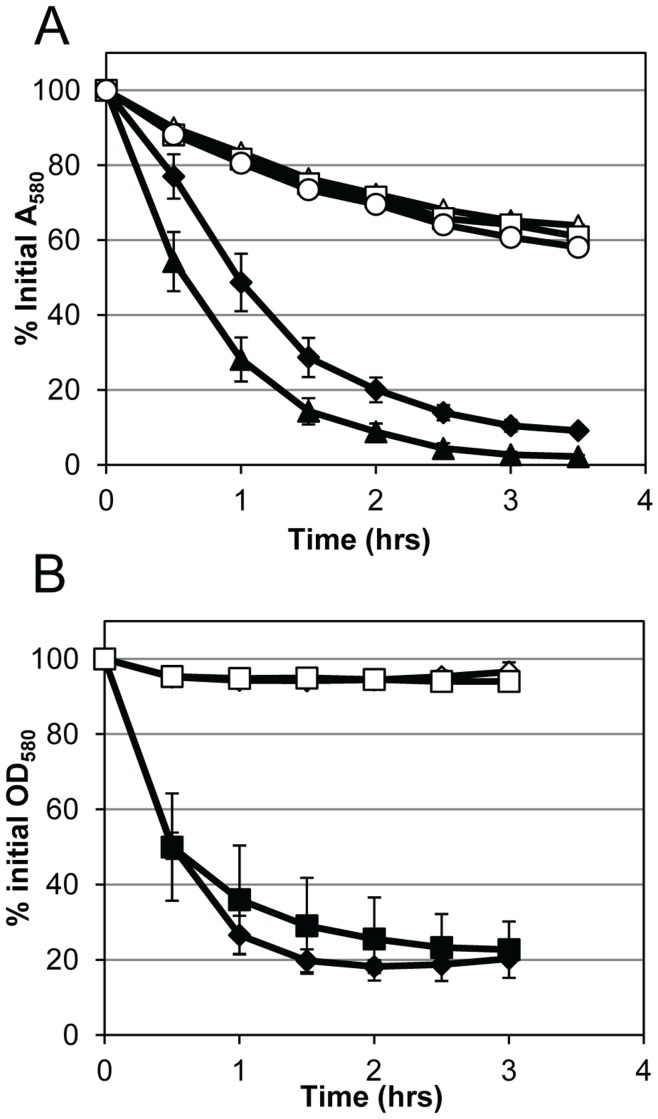
Effect of atl point mutations on murein hydrolase activity.A) Triton X-100 induced autolysis of mid-exponential phase cultures grown in TSB with 1 M NaCl at a 1∶10 media to flask volume ratio. UAMS-1 pJB128 (solid diamonds), ΔatlAM mutant pJB128 (empty triangles), mutant with atlAM complement plasmid pJB111 (solid triangles), mutant with atlAMH263A complement plasmid pJB122 (empty square), and mutant with atlAMH380A complement plasmid pJB123 (empty circles). B) Quantitative murein hydrolase activity of culture supernatants on Micrococcus cells. UAMS-1(pJB128) (solid diamonds), ΔatlGL mutant KB5001 (empty diamonds), mutant with atlGL complement plasmid pJB135 (solid squares), and mutant with atlGLE1129A complement plasmid pJB142 (empty squares). Data represent the mean (n = 2) with standard error.